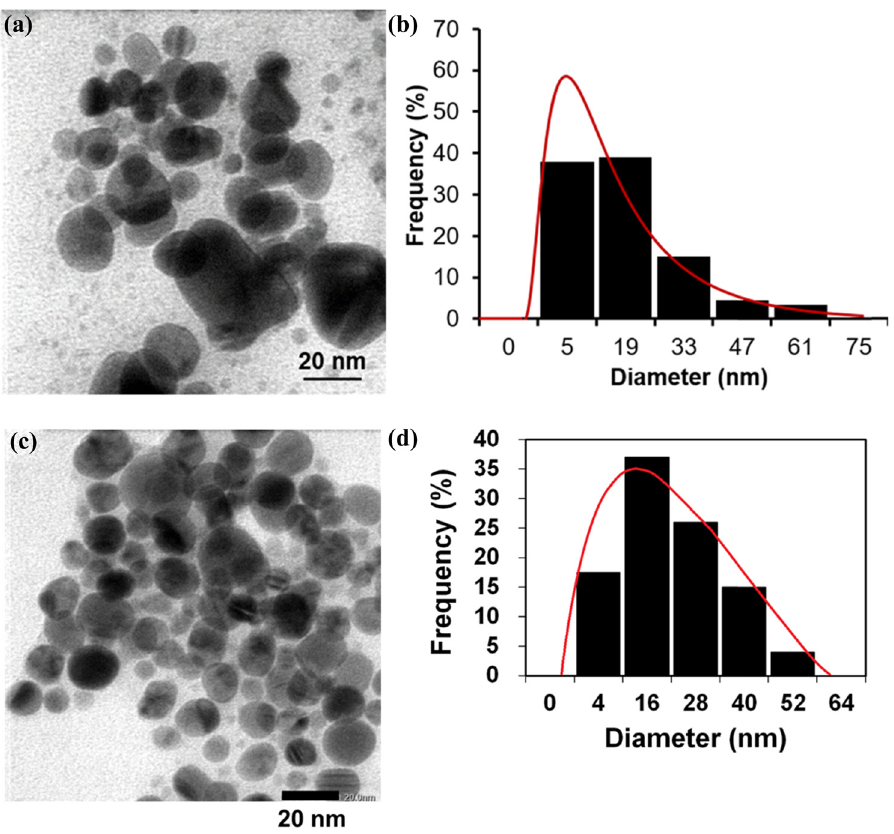
Figure 5: TEM image ( a ) and size distribution ( b ) of OT - AgNPs; TEM images ( c ) and size distribution ( d ) .